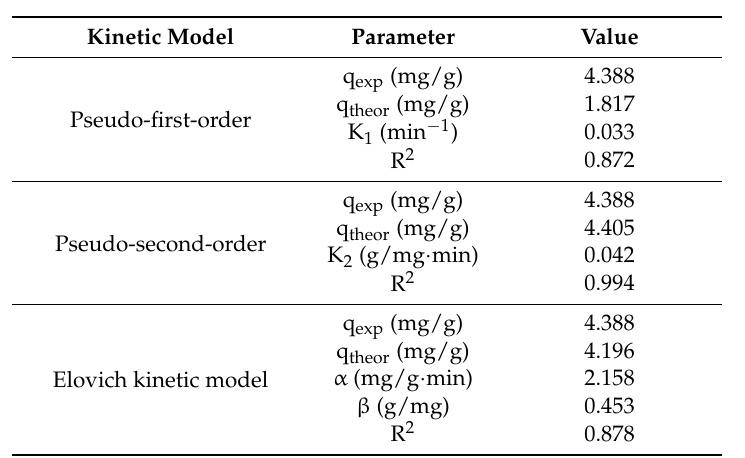
Table 3. Pseudo first-order, second-order and Elovich kinetic parameters for phenol removal on to magnetic ZnO